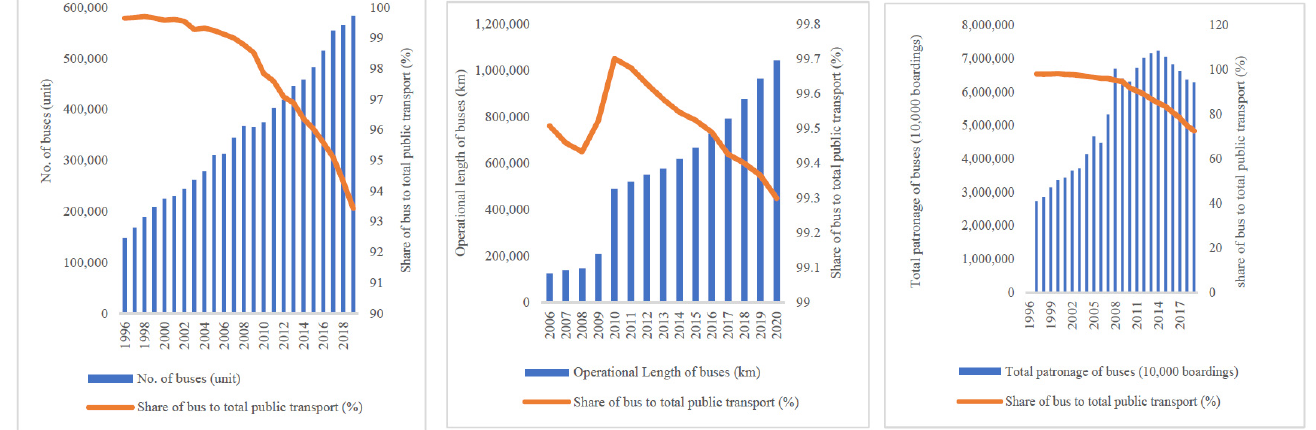
Figure 2. Trends of buses (trolley bus included) in China from 1996 to 2019 Source: data compiled from National Bureau of Statistics, 2020.